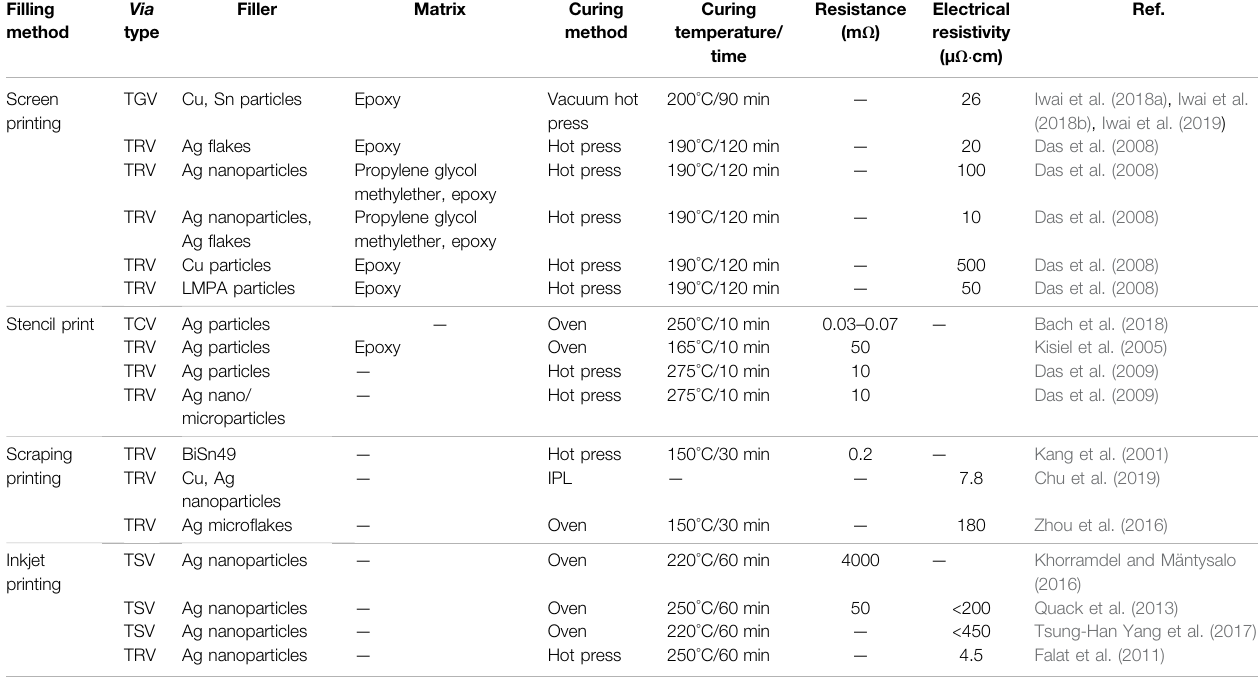
TABLE 2 | Summary of the reported microvia fi lling performance of metal nano/microparticle conductive adhesives/inks. Filling